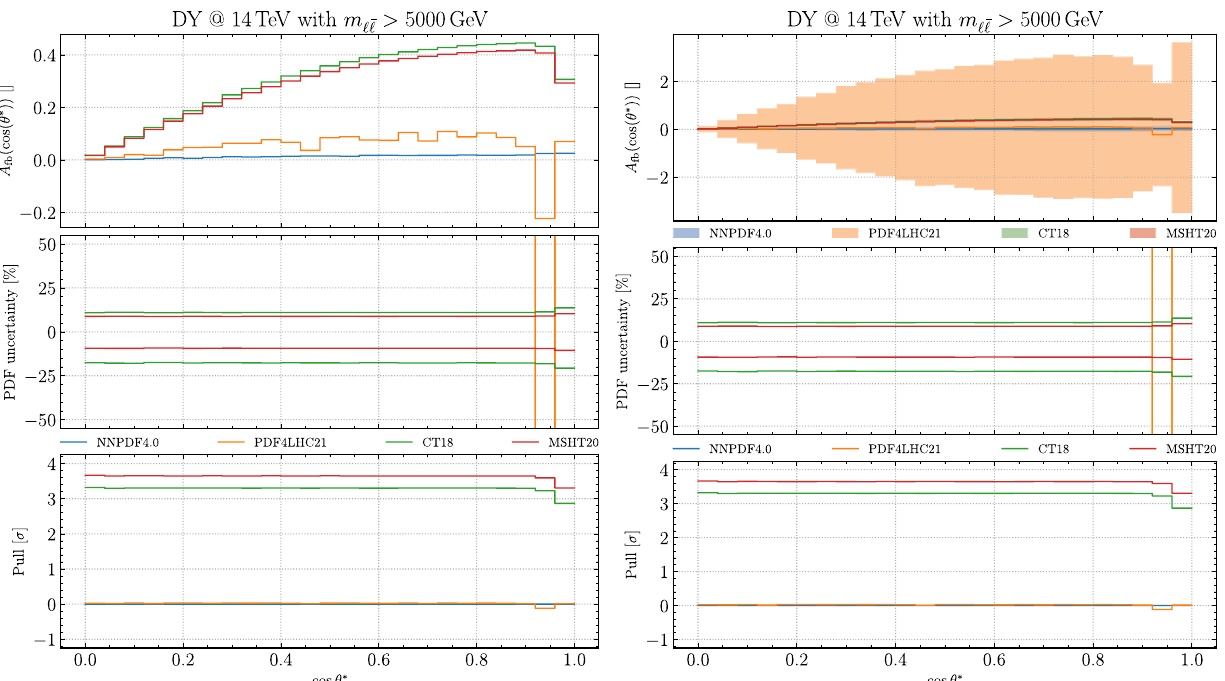
Fig. 21 Same as Fig. 20 (bottom left), now also including the PDF4LHC21 prediction. In the left plot the PDF uncertainty is not shown, in the right plot the scale on the y axis is suitably expanded. Note that the PDF4LHC percentage PDF uncertainty does not show as it falls outside the plot